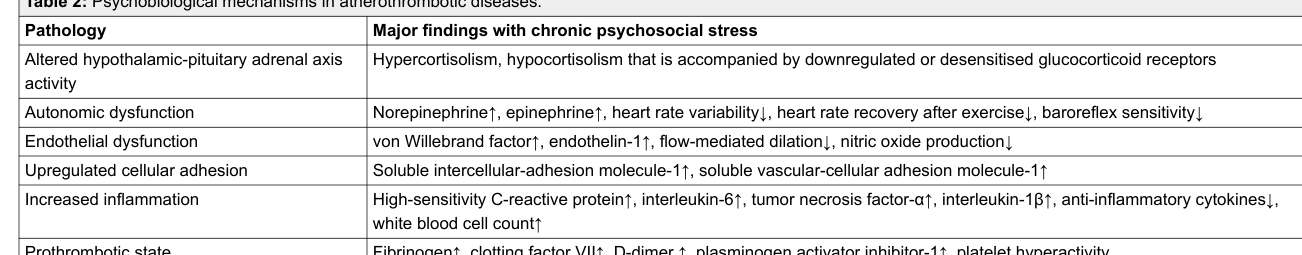
Table 2: Psychobiological mechanisms in atherothrombotic diseases.